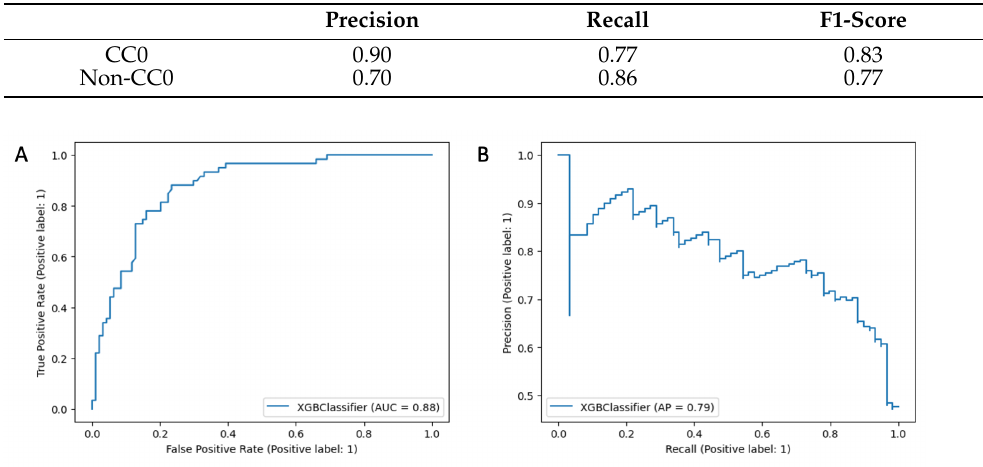
Table A3. XGBoost supervised classification machine learning model that predicts complete cy-